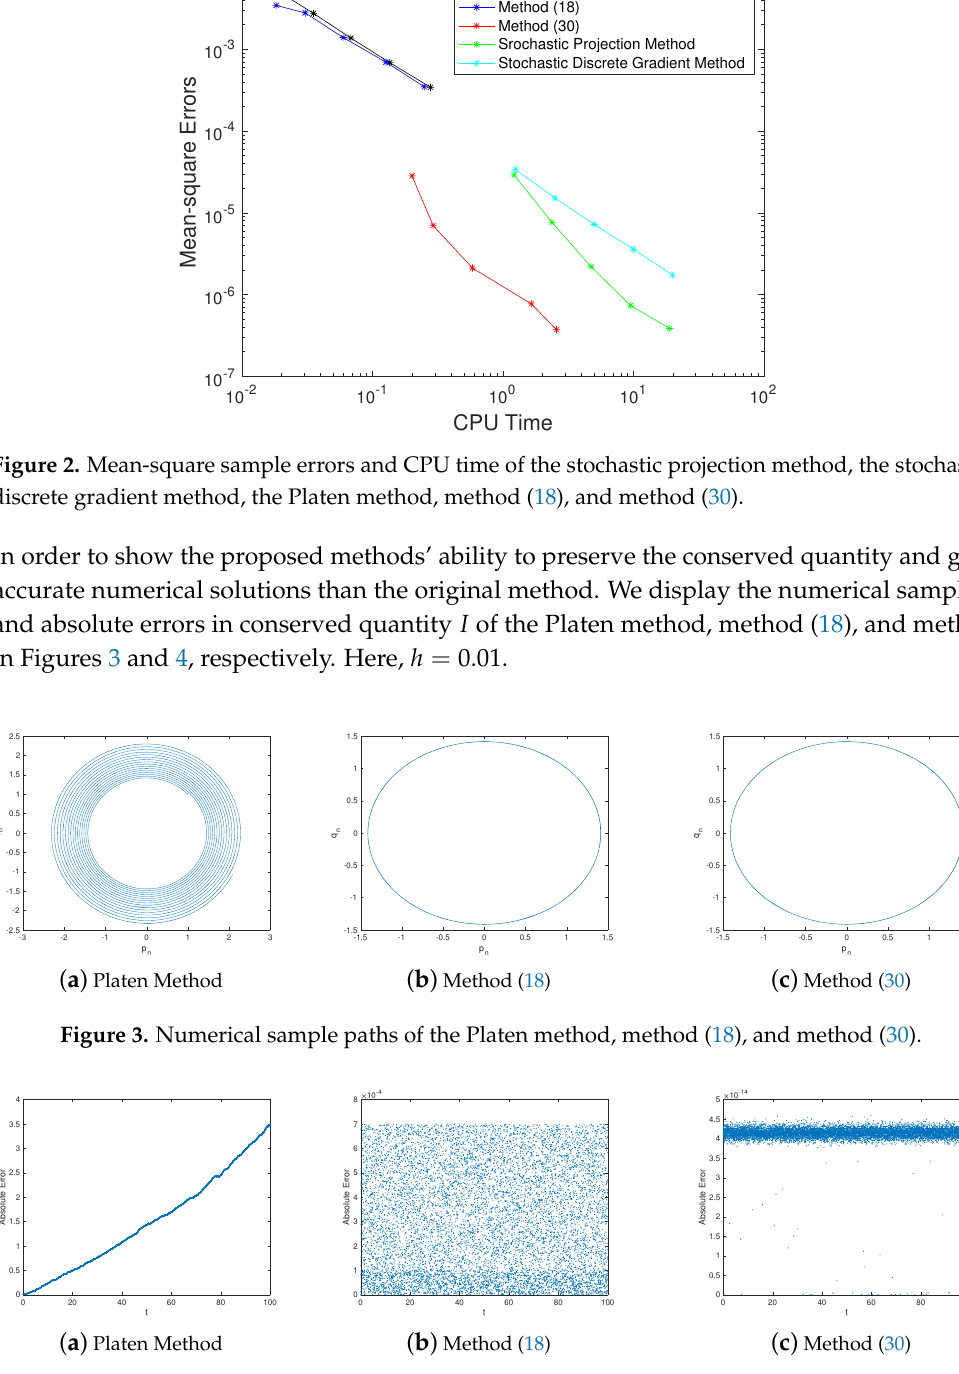
Figure 4. Conserved quantity errors of the Platen method, method (18), and method